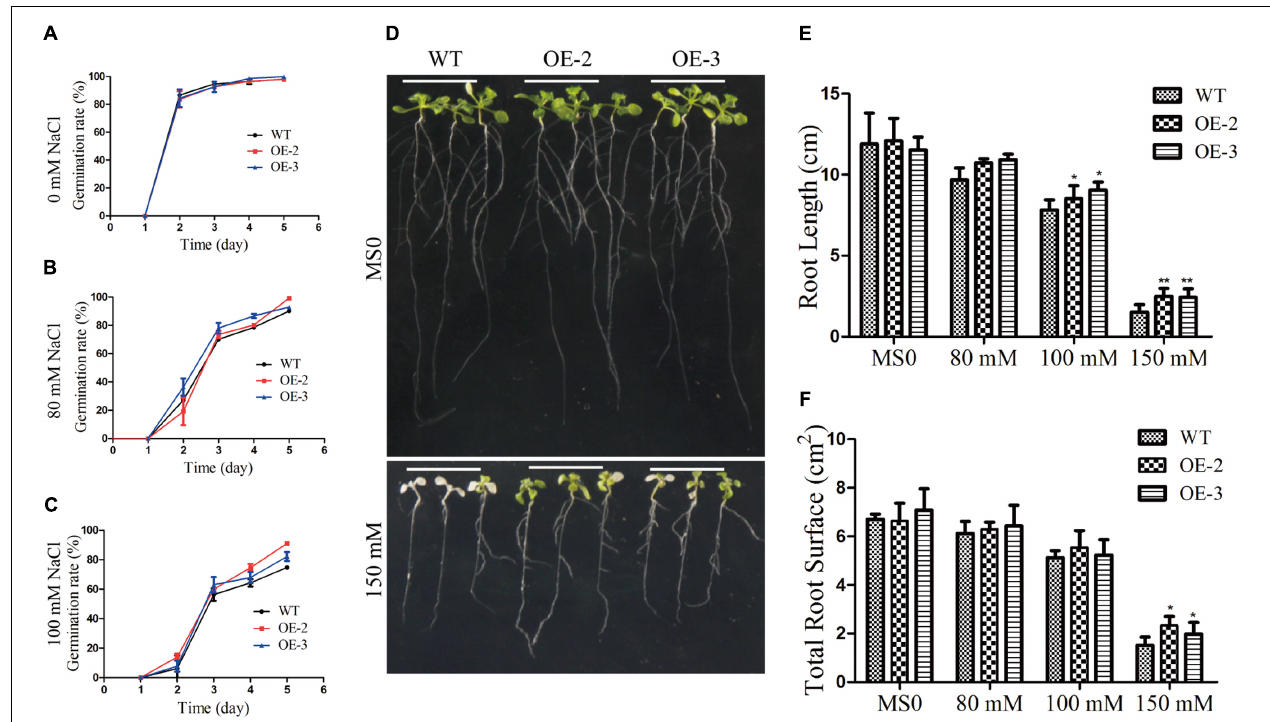
FIGURE 10 | Responses of wild type and transgenic plants to NaCl treatment. (A) Statistical analysis of seed germination on 1/2 MS medium (about 100 seeds for each line). (B) Statistical analysis of seed germination on 1/2 MS medium with 80 mM NaCl. (C) Statistical analysis of seed germination on 1/2 MS medium with 100 mM NaCl. (D) Phenotypes of WT and transgenic seedlings under NaCl treatment. Four-day-old seedlings of two transgenic lines and WT Arabidopsis were planted on 1/2 MS medium with or without NaCl for 10 days. (E) Comparative root lengths of WT and transgenic lines. (F) Total root surface of WT and transgenic lines. The data are shown as mean ± SD ( n = 27). Independent t -tests demonstrated that there was (very) significant difference ( ∗ P < 0.05 or ∗∗ P <